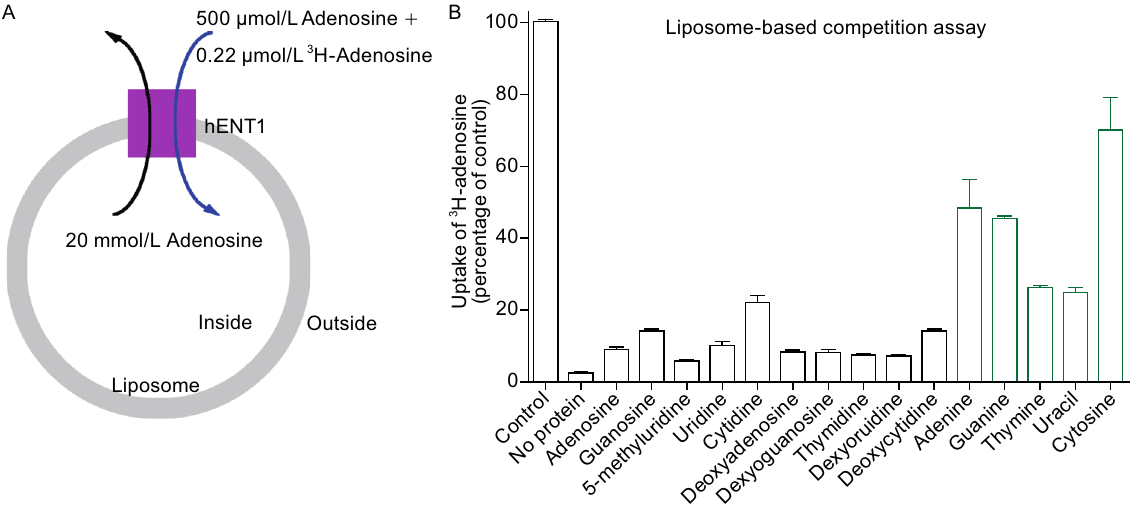
Figure 4. Substrate speci fi city of hENT1. (A) A schematic diagram of the competition assay. The proteoliposomes were preloaded with 20 mmol/L unlabeled adenosine, then diluted into 100 μ L assay buffer containing 0.22 μ mol/L 3 H-adenosine and 500 μ mol/L competitor - one of the listed nucleosides and nucleobases in panel B. (B) Transport activity for nucleosides, deoxynucleosides, and nucleobases. The transport of 3 H-adenosine by recombinant hENT1 protein was examined in the proteoliposome-based counter fl ow assays in the presence of the indicated nucleosides, deoxynucleosides, and nucleobases. Control refers to the condition where no other substrate was added. No protein refers to the condition where protein-free liposomes were used. The black boxes represent the transport activity of nucleoside and deoxynucleoside for hENT1, whereas the green boxes represent the transport activity for nucleobase. Each data point represents the average of at least three independent experiments. The error bars represent standard deviation